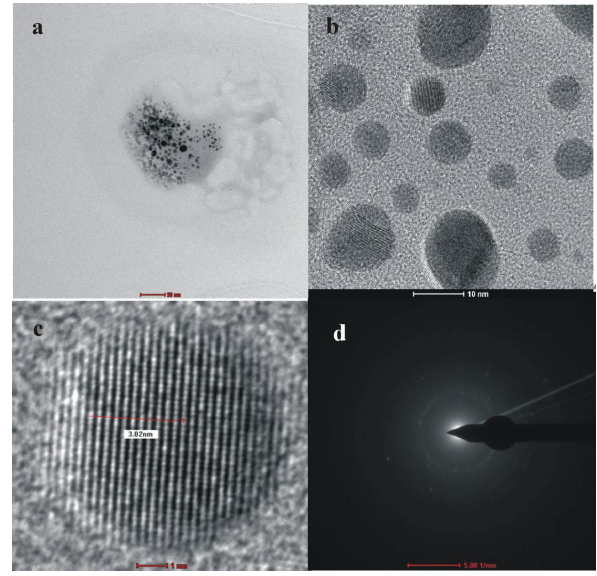
Figure 13. Panel (a) shows the TEM image, (b) , (c) HRTEM im- ages, and (d) SAED pattern of an O-, S-, and K-containing particle aggregation sampled using a PVC pipe in a fault near a concealed ore body of the Dongshengmiao